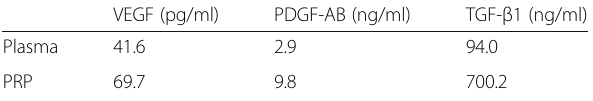
Table 2 Concentration of VEGF, PDGF-AB, and TGF- β 1 in plasma and